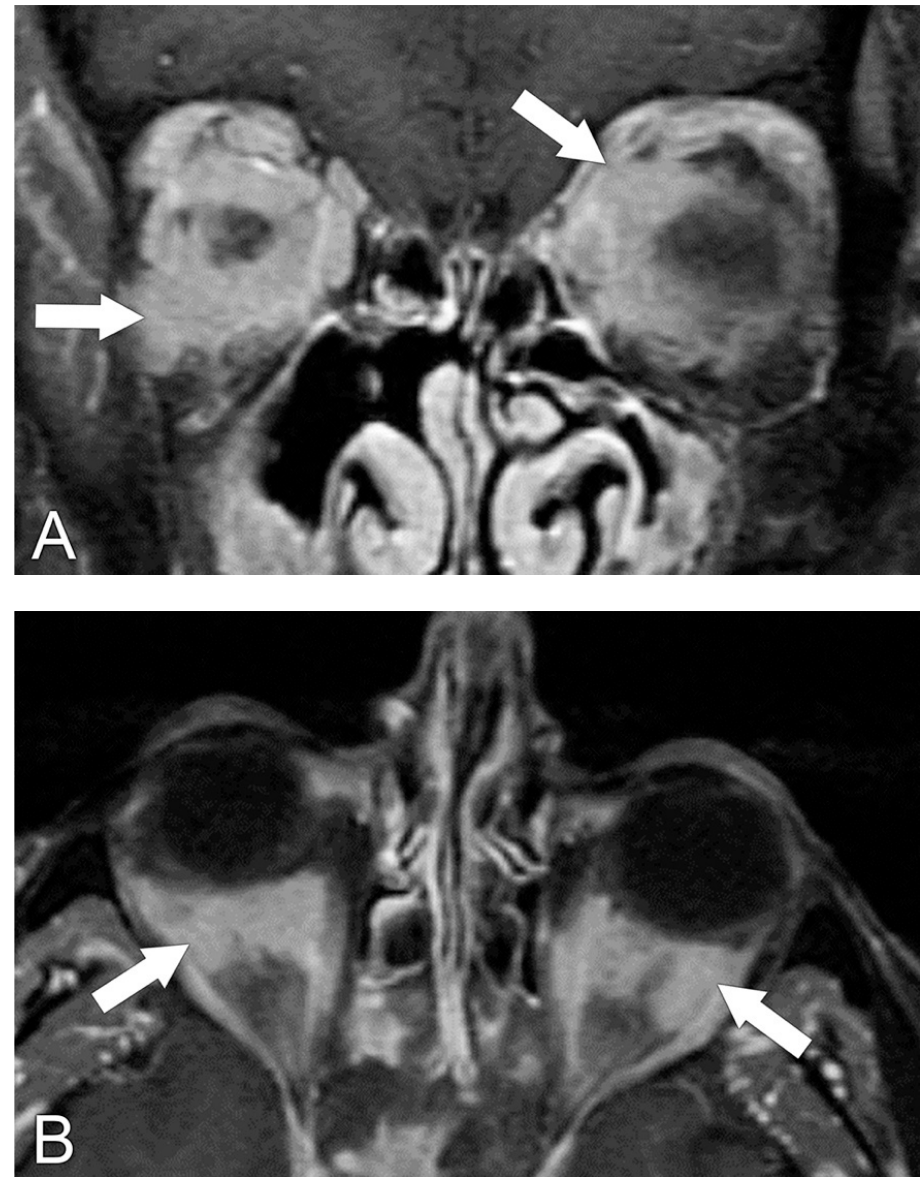
Figure 6. Erdheim–Chester disease. ( A ) Coronal T1 post-contrast MRI sequence shows extra-ocular muscle enlargement and disease in bilateral retrobulbar spaces (arrows). ( B ) Axial T1 post-contrast MRI sequence shows the disease in the bilateral intraconal spaces. Orbital lymphoma accounts for 2% of lymphomas, making it the most common primary orbital malignancy in adults [68]. The sites of involvement of orbital lymphoma include the EOMs and retrobulbar fat (Figure 7), eyelid, conjunctiva, and lacrimal gland. When lymphoma involves EOM, the presentation is usually painless and unilateral with associated tendon thickening and involvement of the tendinous insertion. MRI findings in patients with orbital lymphoma tend to be nonspecific with T1 and T2 homogeneous enhancement and an isointense signal intensity